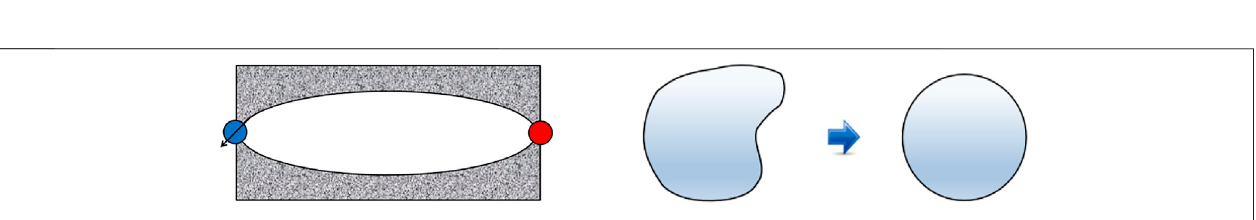
FIGURE 5 | Physical model of single cavity in one injection-production